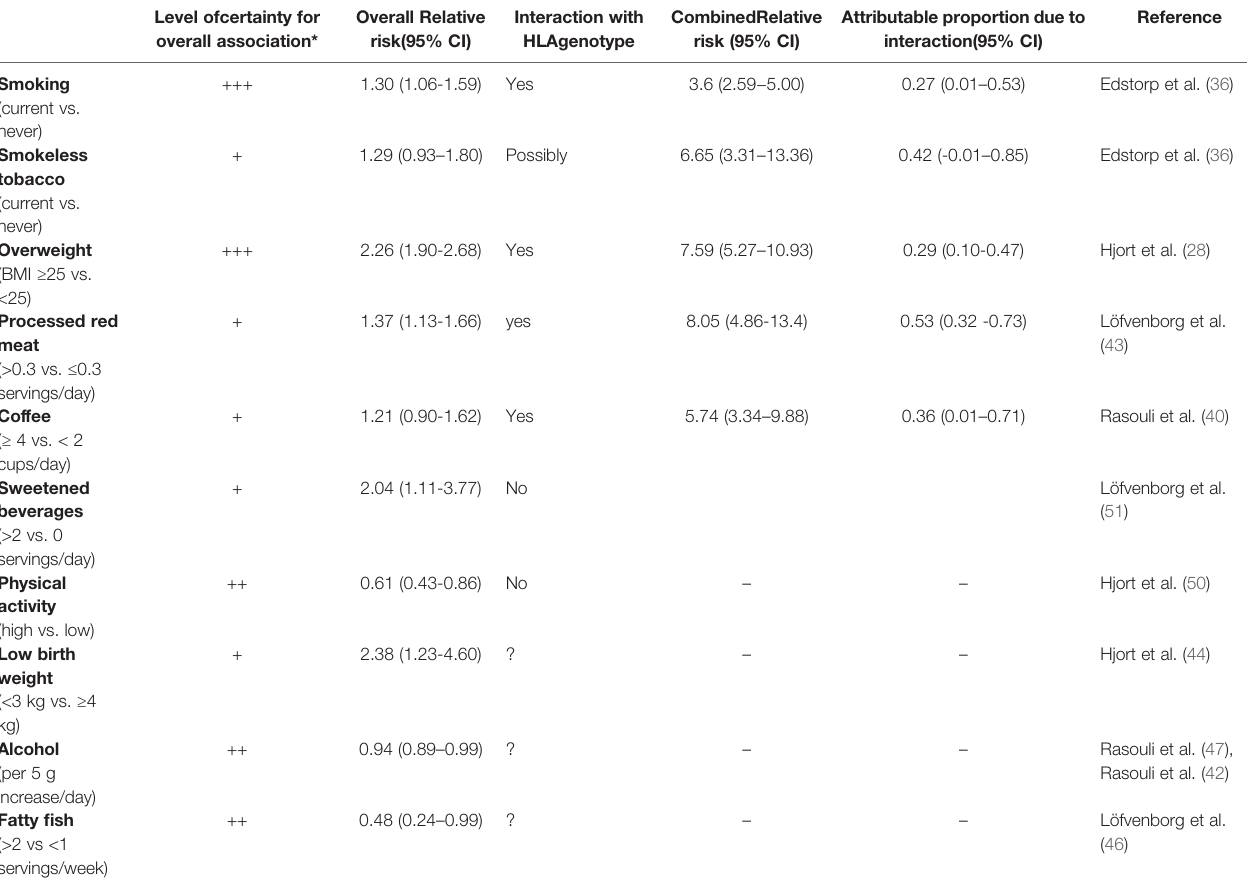
TABLE 1 | Summary of tentative lifestyle risk factors for LADA and their potential interaction with HLA risk